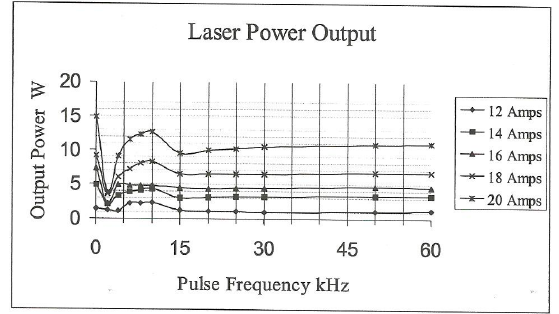
Figure 1. Laser power as a function of pulse frequency and lamp current for the Rofin Sinar 90 W flash-lamp, pumped, Q-switched yttrium aluminum garnet (Nd:YAG) laser. Scan line overlap was ~50% of line width, and the peak power density was 1.4 GW/cm 2 . Line